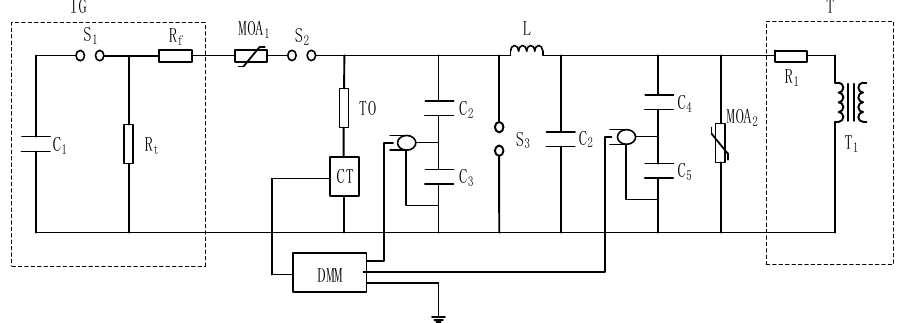
Figure 6. Power frequency freewheeling test circuit diagram.